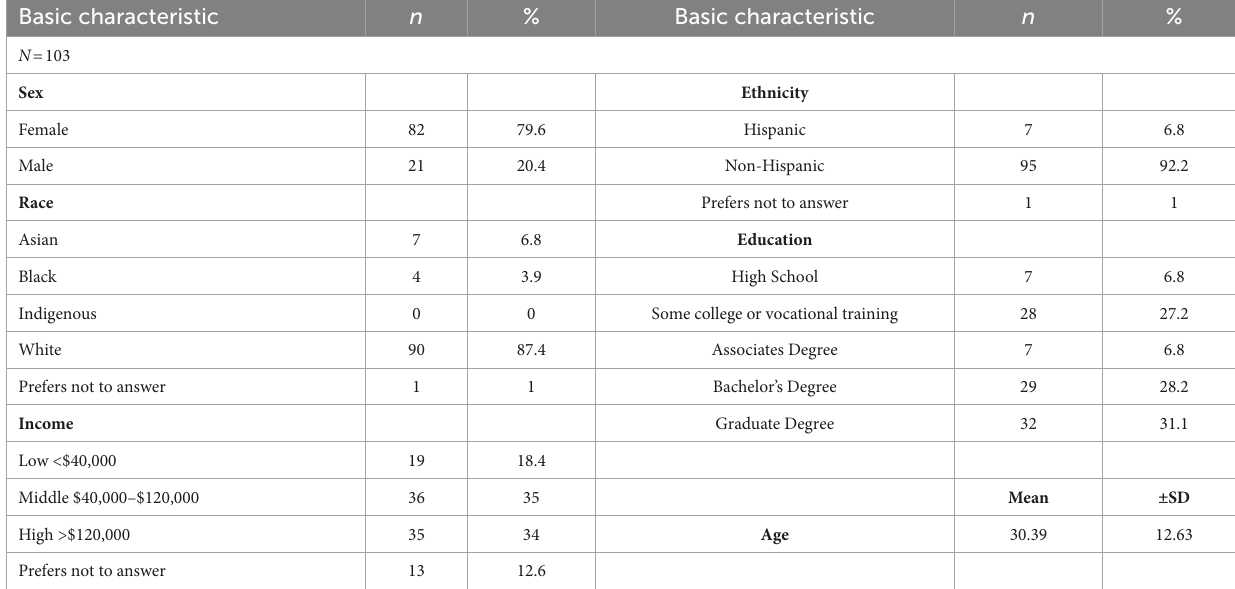
TABLE 2 Demographic data for all 103 participants in the study. Basic